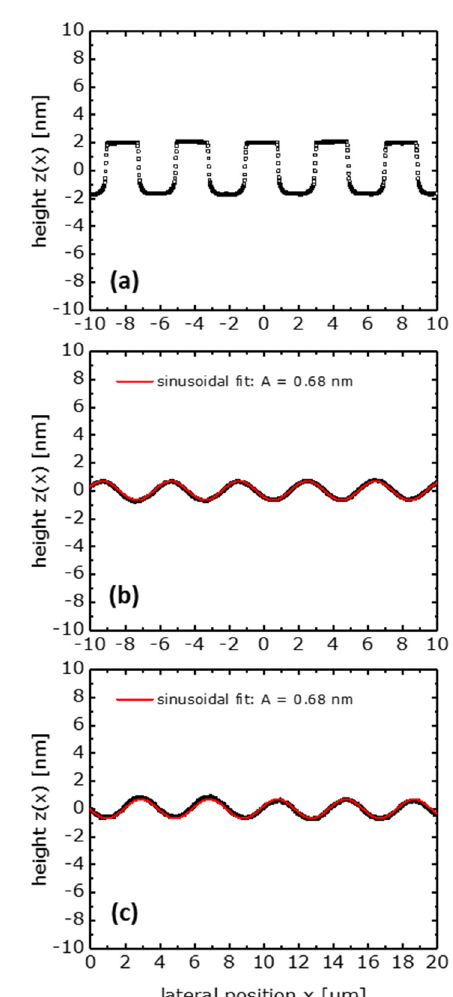
Fig. 2. AFM measurements of surface profiles with 4 µm period for (a) the initially binary grating in Si, (b) the sinusoidal profile after resist planarization and the final profile (c) after Au coating. The open symbols correspond to the measured AFM profile averaged over 256 scan lines, the red line is a sinusoidal fit to the measured profile.